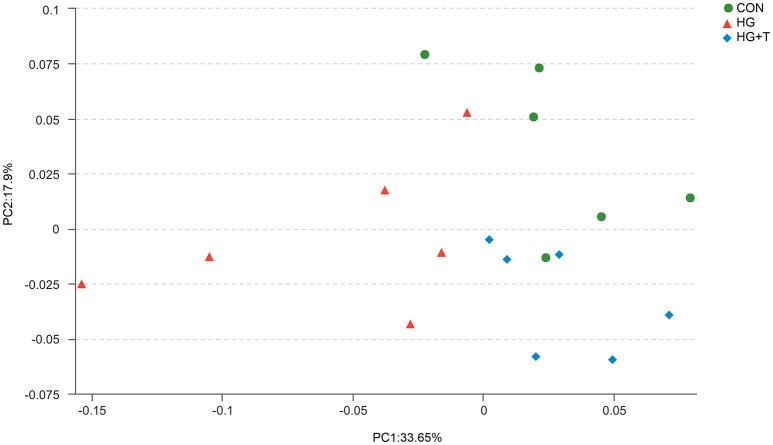
Principal coordinate analysis (PCoA) of bacterial community structures of the ruminal microbiota in CON (green circles), HG (red triangle), and HG+T (blue diamond) groups. PCoA plots were constructed using the unweighted UniFrac method. CON, control diet; HG, high grain diet; HG+T, high grain diet supplemented with 180 mg thiamine/kg DMI.